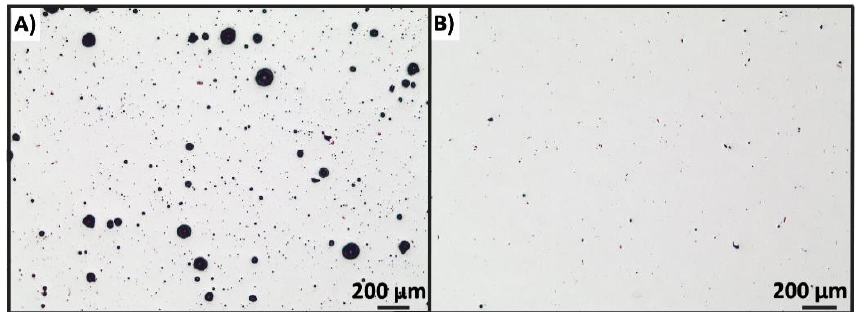
Figure 6. Optical microscope images of sections (parallel to the XZ plane) of cubes printed with the following parameter combinations. ( A ) h = 0.24 mm; v = 800 mm/s; ( B ) h = 0.1 mm; v = 1800 mm/s.